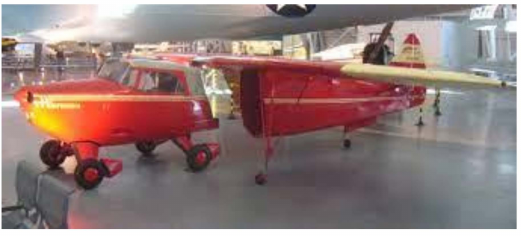
Figure 3. Fulton Airphibian [22].